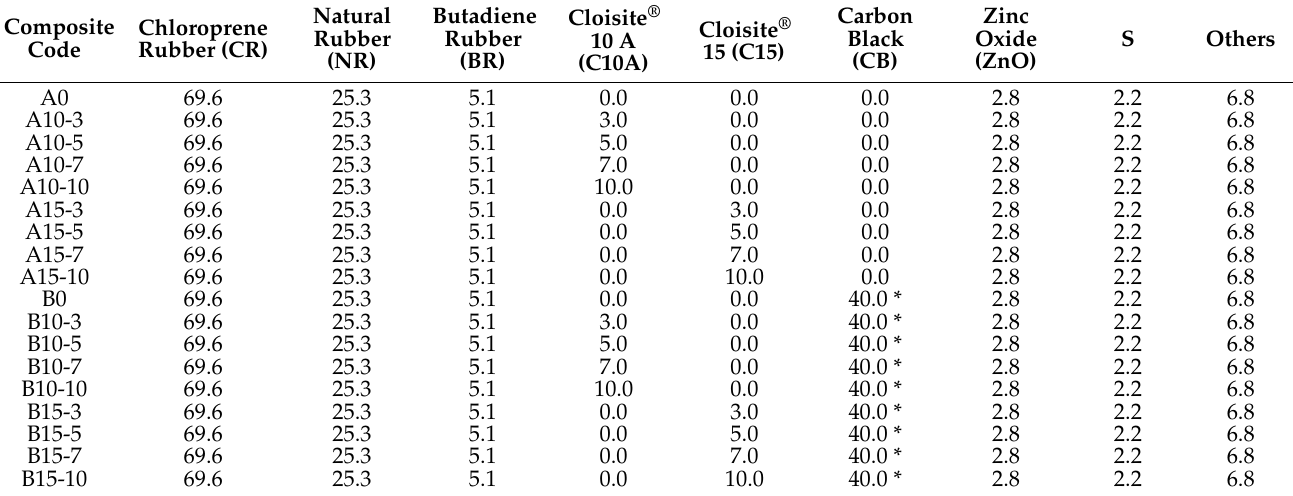
Table 2. Recipes for rubber nanocomposite. Quantities are given in parts per hundred rubber (phr). Composite